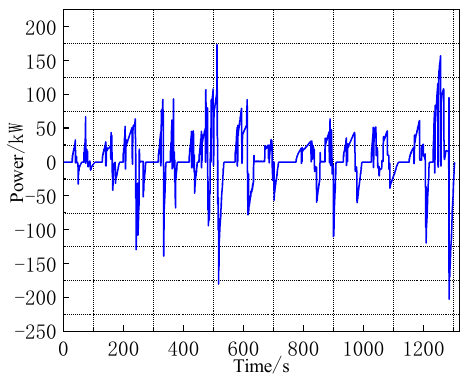
Figure 12. The required power of China city road cycle.